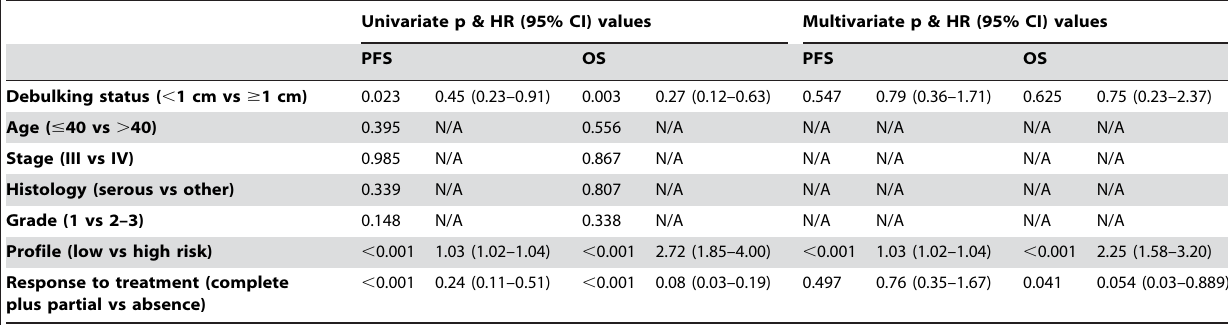
Table 1. Univariate and multivariate analysis for PFS and